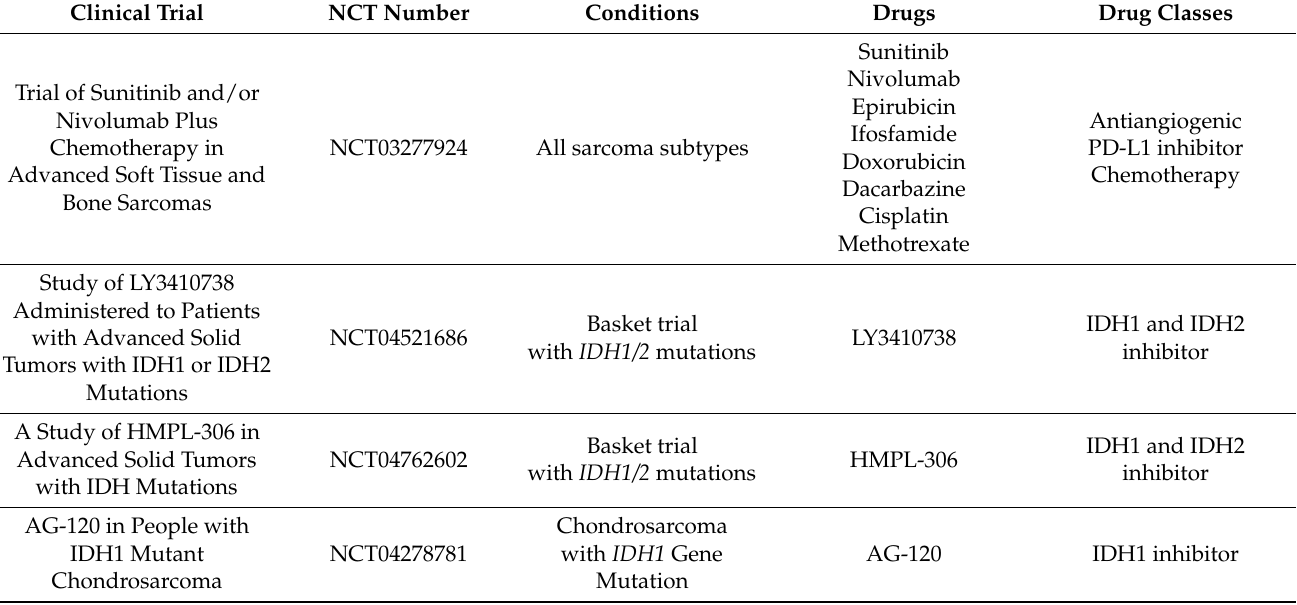
Figure 3. Schematic illustration of key signaling pathways underpinning chondrosarcoma genesis. The figure represents the main biological pathways (in blue) activated in conventional and dediffe- rentiated chondrosarcomas. The potential therapeutic agents which could target these pathways are represented in red. All the mentioned pharmacological agents in this figure are under evaluation in ongoing clinical trials. Table 2. Ongoing clinical trials for chondrosarcomas